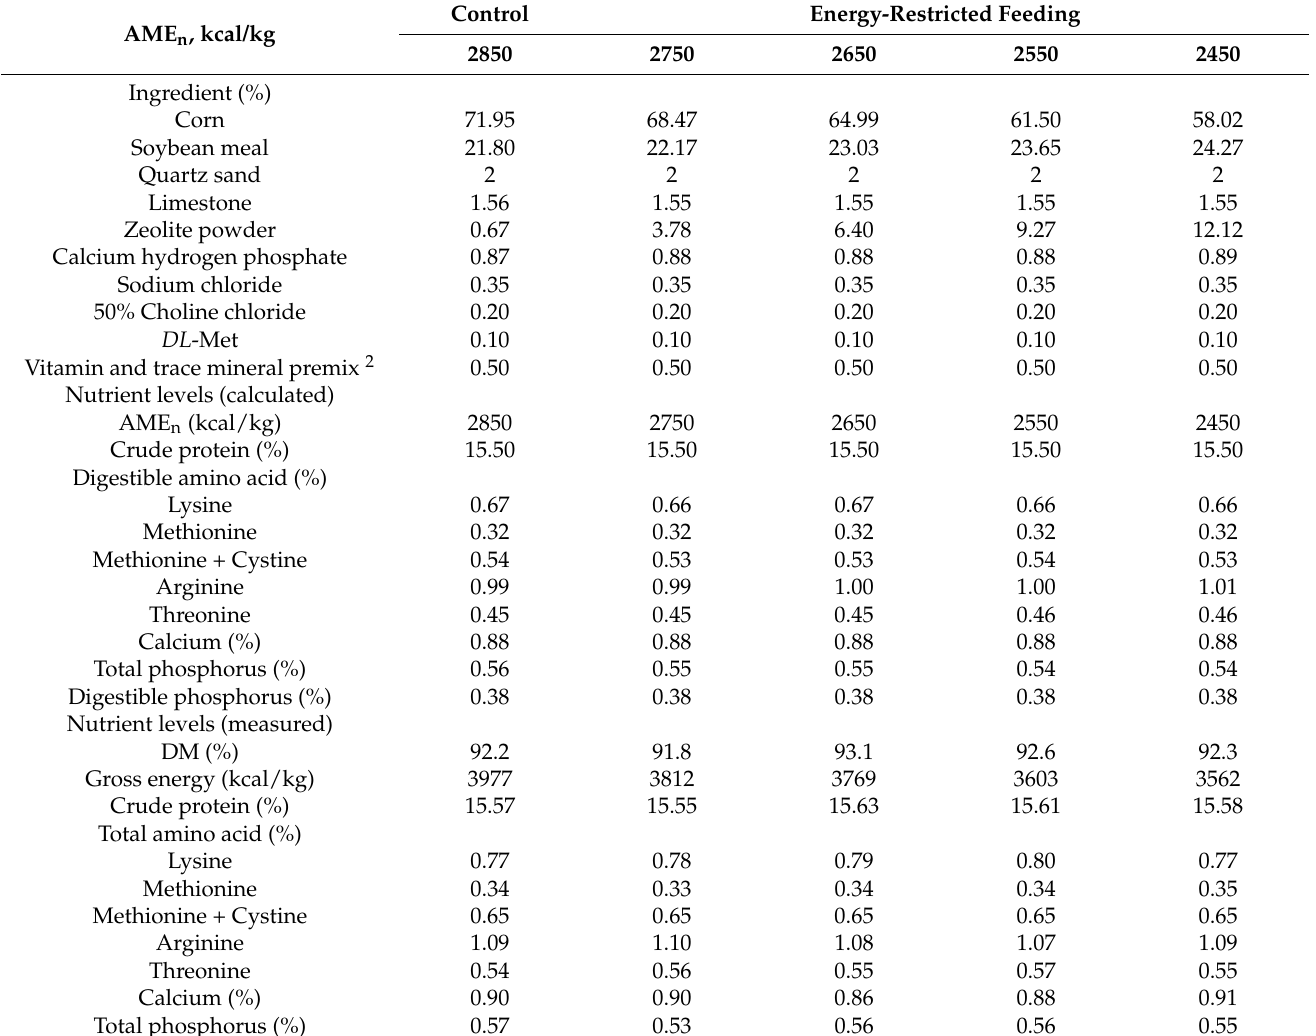
Table 1. Ingredients and nutrient levels of experimental diet provided from 8 to 18 weeks of age.